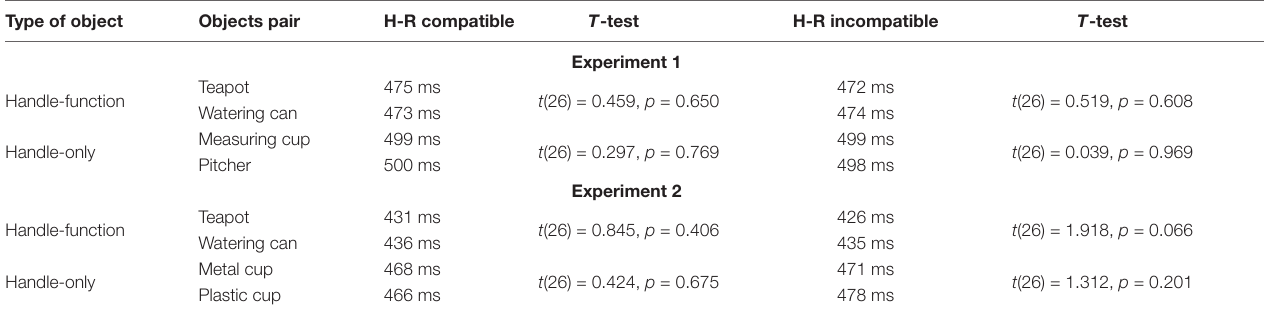
TABLE 3 | Results from multiple paired sample t -tests performed separately for each Experiment (1, 2), type of object pair (handle-function, handle-only), and compatibility condition (H-R compatible, H-R incompatible). Type of